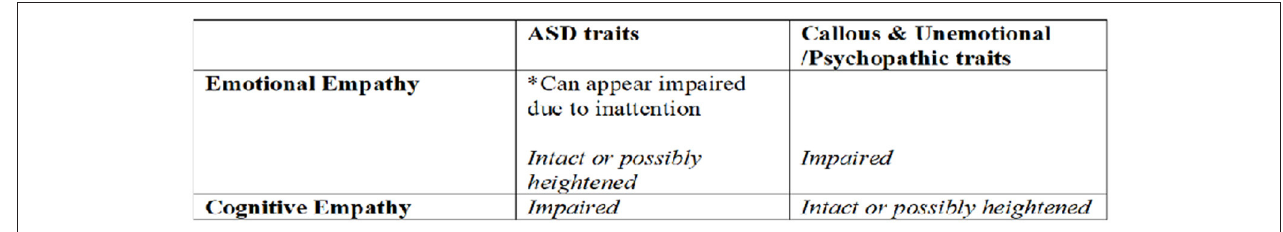
FIGURE 4 | Theoretical Model of distinct types of empathy deficits amongst those with distinct clinical traits.